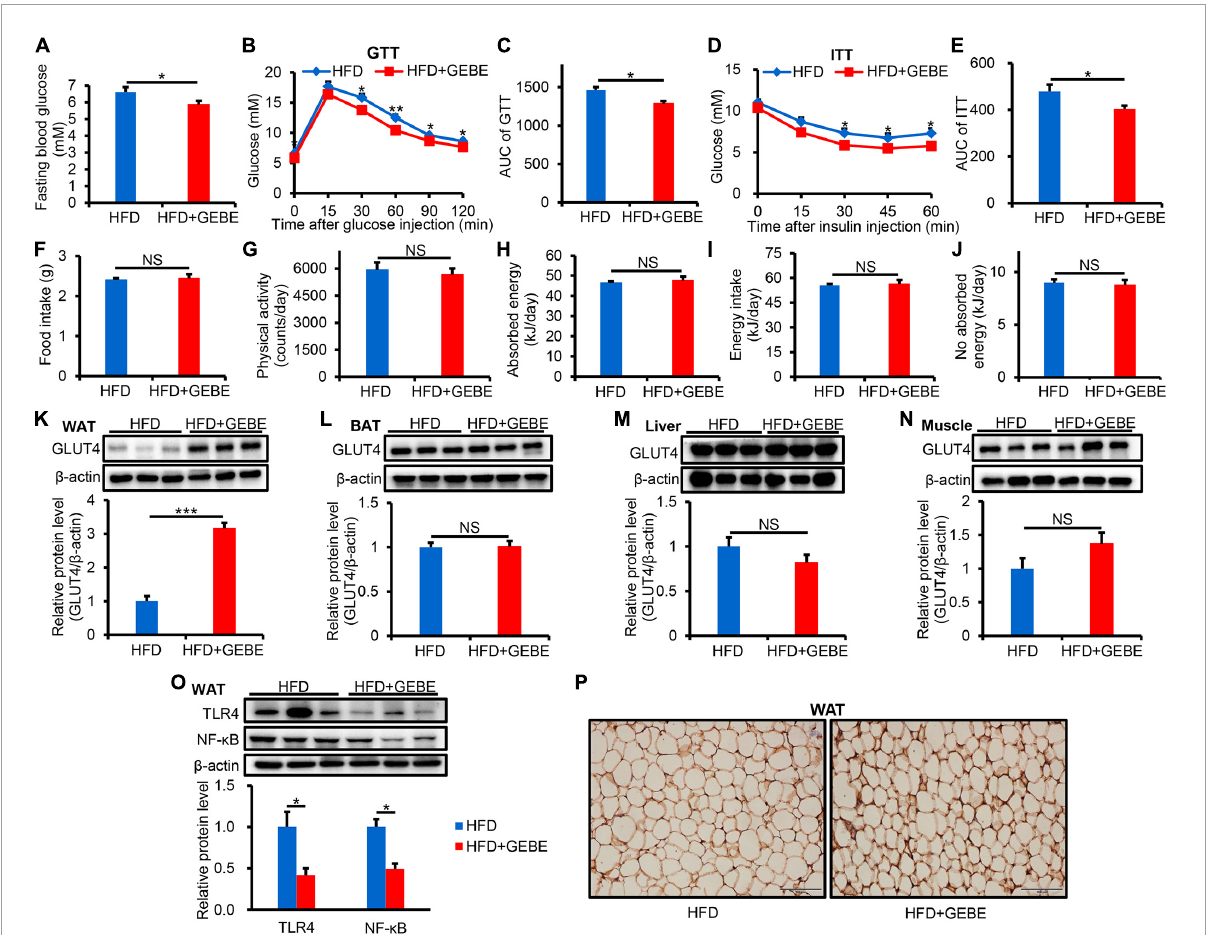
FIGURE1 The effects of GEBE on glucose metabolism and inflammation in HFD-induced C57BL/6 mice. HFD-induced C57BL/6 mice were treated with GEBE (200 mg/kg) for 8 weeks by daily oral gavage ( n = 8–10). (A) Fasting blood glucose. (B,C) GTT and the AUC for the GTT. (D,E) ITT and the AUC for the ITT. (F) Food intake. (G) Physical activity. (H) Absorbed energy. (I) Energy intake. (J) No absorbed energy. (K–N) Western blotting analysis of GLUT4 expression in WAT, BAT, Liver, and Muscle. (O) Western blotting analysis of inflammation-related proteins expression in WAT. (P) Immunohistochemical staining for GLUT4 in WAT. Magnification is 200 × , Scale bar = 100 µ m. * p < 0.05, ** p < 0.01, and *** p < 0.001. NS, not statistically significant. The results are presented as mean ± SEM. HFD: High-fat diet; HFD + GEBE: High-fat diet with